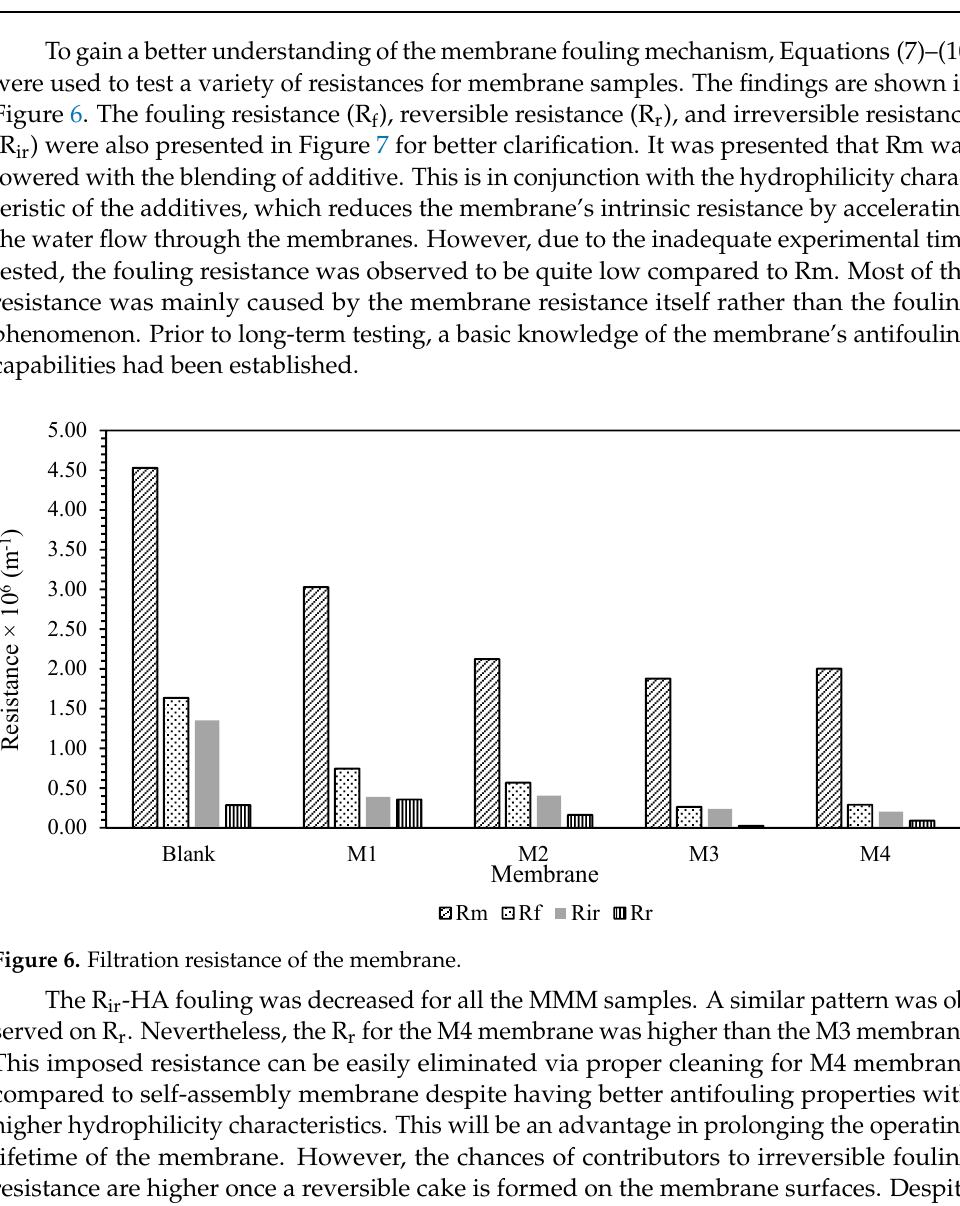
0.00 Figure 7. R f , R r , and R ir of the membrane samples. The R ir -HA fouling was decreased for all the MMM samples. A similar pattern was observed on R r . Nevertheless, the R r for the M4 membrane was higher than the M3 mem- brane. This imposed resistance can be easily eliminated via proper cleaning for M4 mem- brane compared to self-assembly membrane despite having better antifouling properties